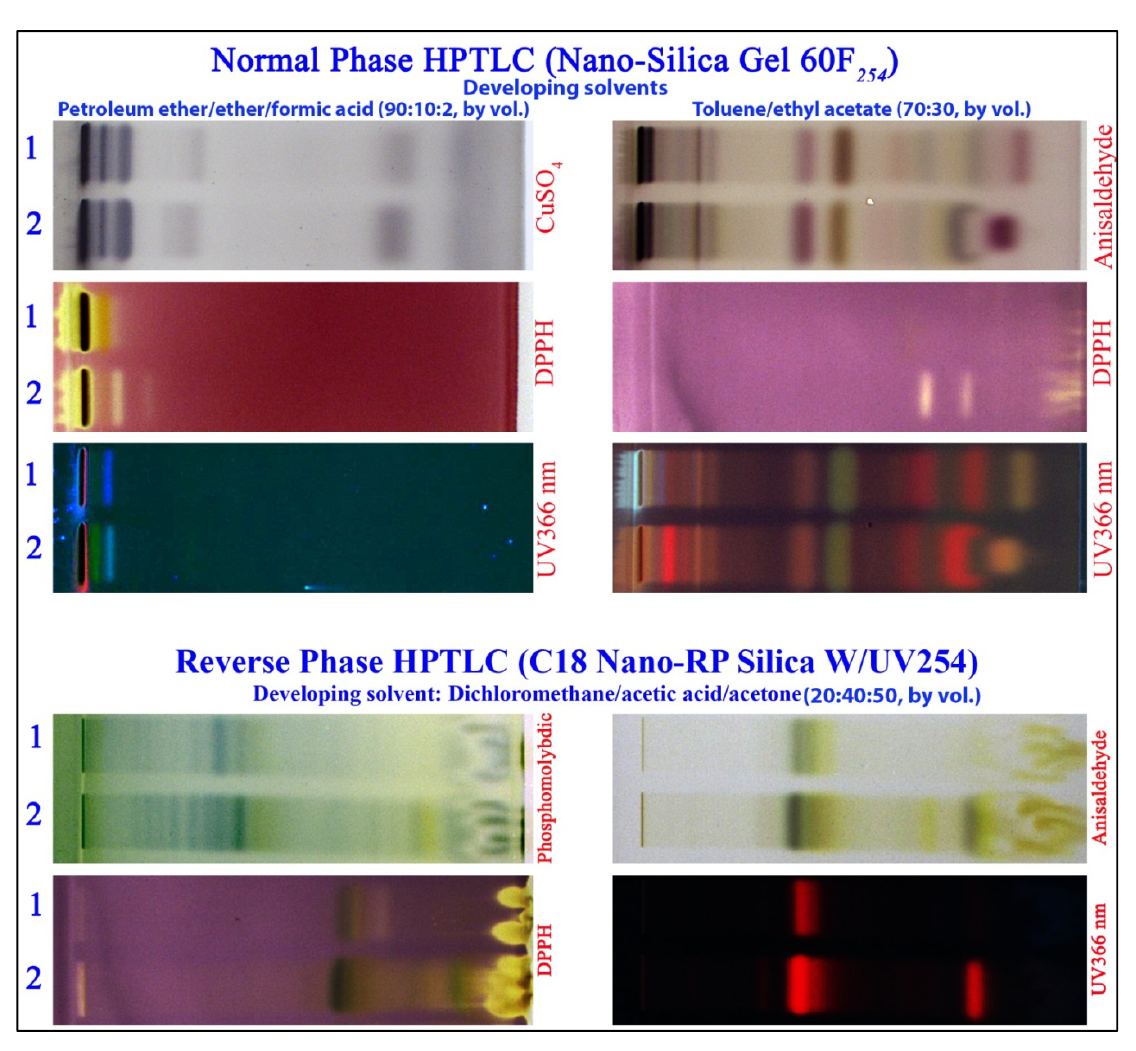
Figure 4. HPTLC profiles of Rumex dentatus (1) and Rumex vesicarius